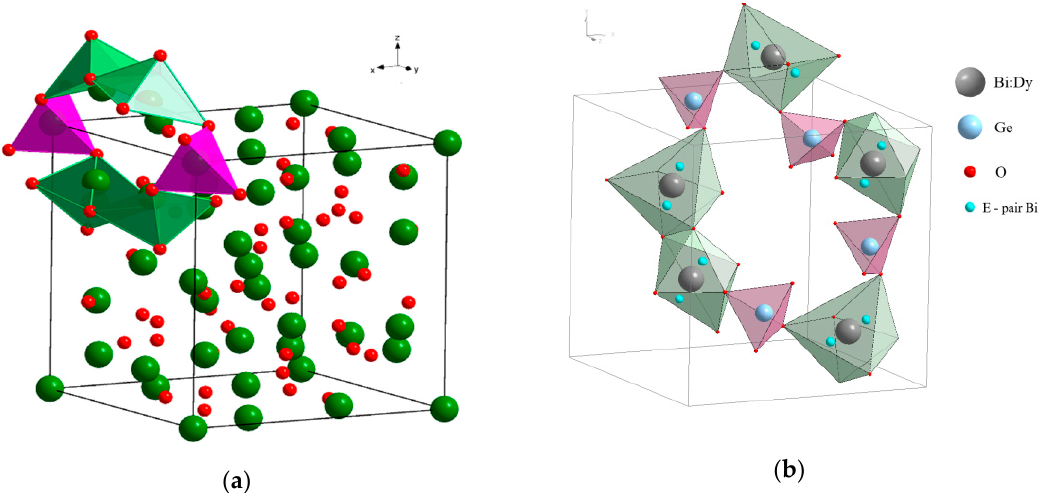
Figure 6. Coordination polyhedra in the ( a ) Bi 24 M 2 O 40 and ( b ) Bi 4 Ge 3 O 12 structures.